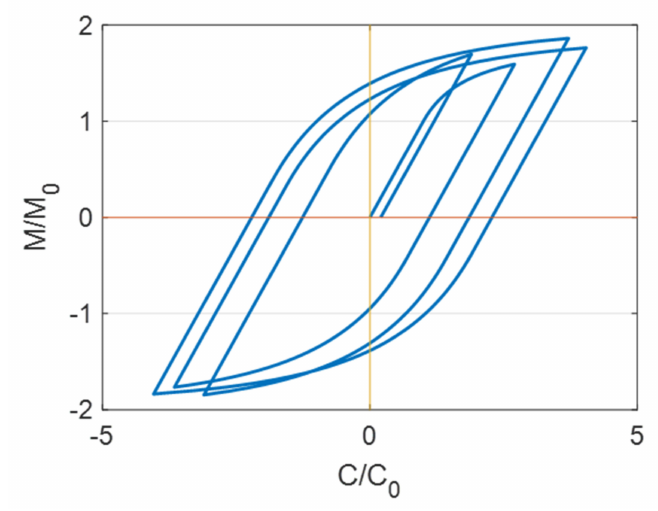
Figure 10. Normalized moment as a function of normalized curvature during leveling.